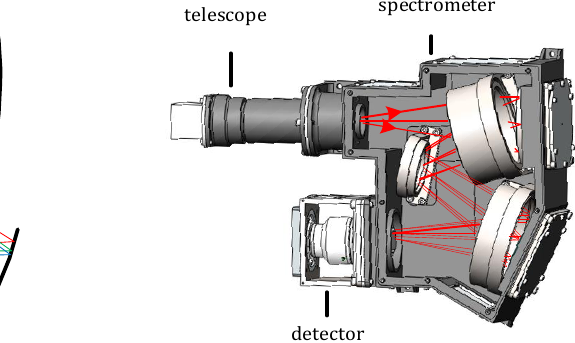
Figure 4. MTF curves of the spectrograph at wavelengths of ( a ) 1000 nm and ( b ) 2000 nm. 3.3. Tolerance Analysis Tolerance analysis can elucidate the fabrication and alignment difficulty of the system. We performed tolerance analysis for the spectrograph. The tolerance items included the surface/element tilt, surface/element decenter, thickness, and surface irregularity. These values are loose in the actual system. The diffraction MTF at 1800 nm wavelength was applied as the nominal tolerance criterion. Table 2 shows the six items that have the greatest effects on the MTF. The analysis results are as follows. Table 2. Sensitive terms influencing the system in the tolerance analysis. Tolerance Item Element